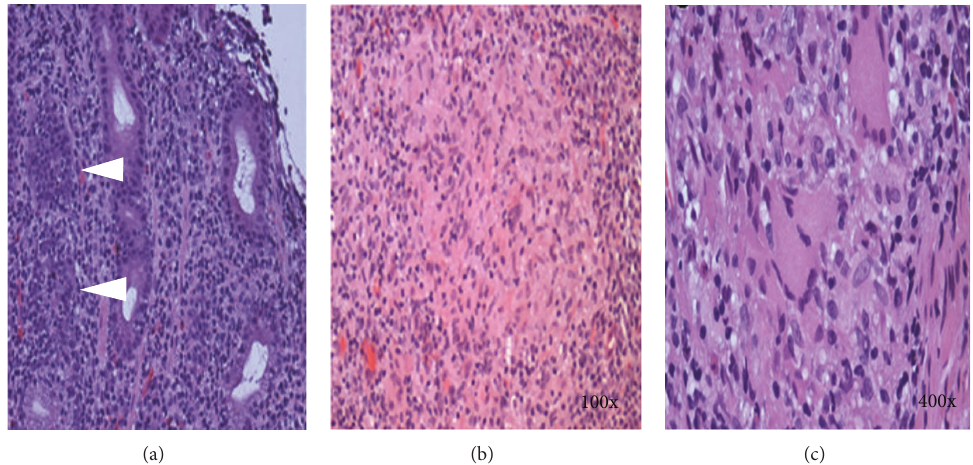
Figure 2: Histopathology of the upper gastrointestinal endoscopic biopsies revealing several small noncaseating epitheloid cell granulomas (arrow heads) and without any evidence of dysplasia or intestinal metaplasia (b) (100x) (c) (400x) showing the noncaseating granuloma.